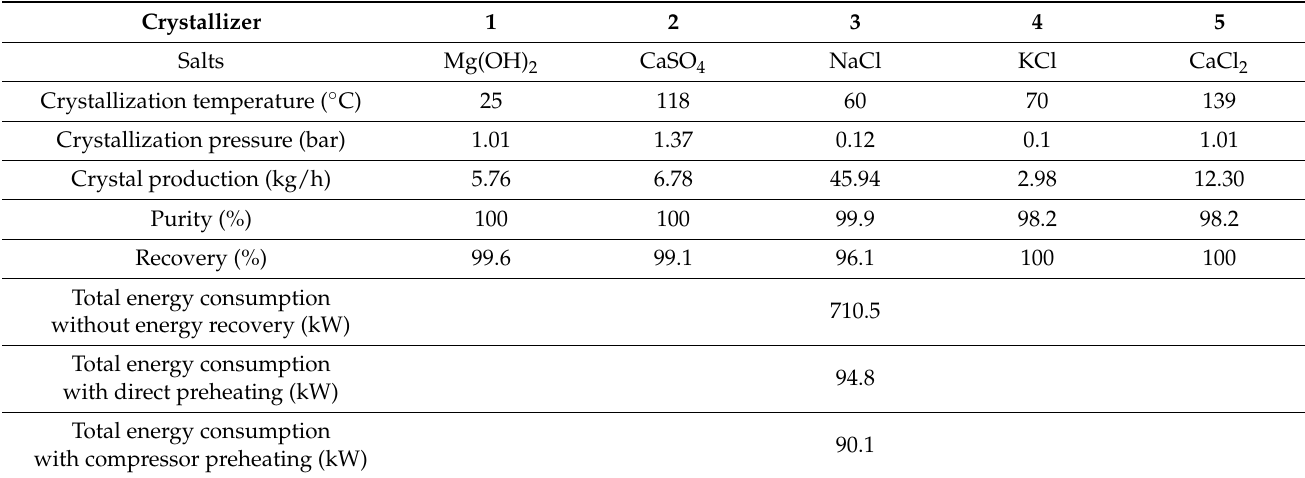
Table 2. Crystallization conditions and simulations results for the multi-crystallization system for desalination brines